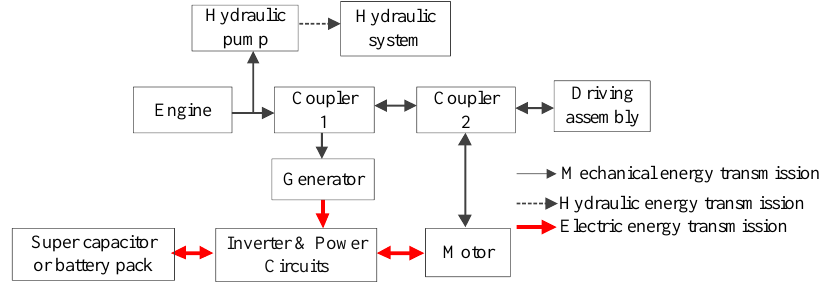
Figure 8. Typical configuration of series–parallel oil–electric hybrid system